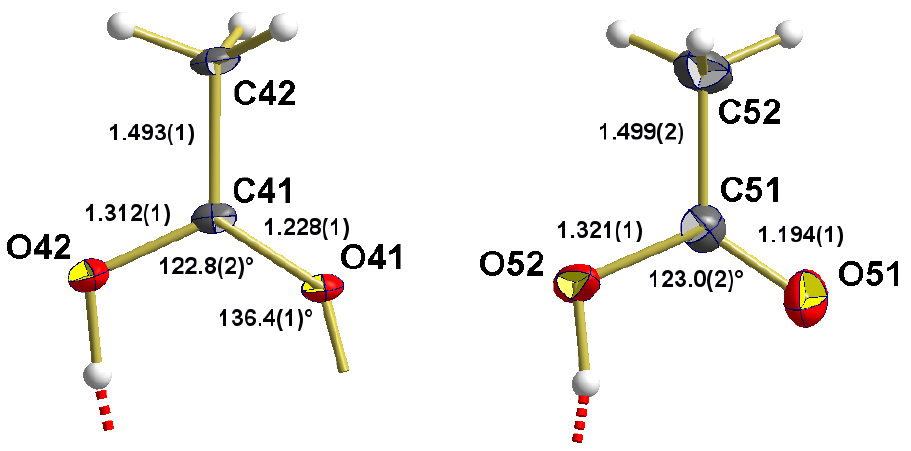
Figure 7. Coordination modes and hydrogen bonding of the acetate acid molecules in the RE(OAc) 3 · 2AcOH structure type visualized for RE = Nd. C-C and C-O bond lengths [Å ] arithmetically averaged over all 4 compounds, standard deviations of averaging in brackets. Bonds from oxygen to RE are indicated by short sticks, hydrogen bonds by short, dashed sticks in red. Table 4. Bond lengths [Å ] within the different acetic acid molecules of the RE(OAc) 3 ·2AcOH struc- ture type with mean values and standard deviations in brackets.